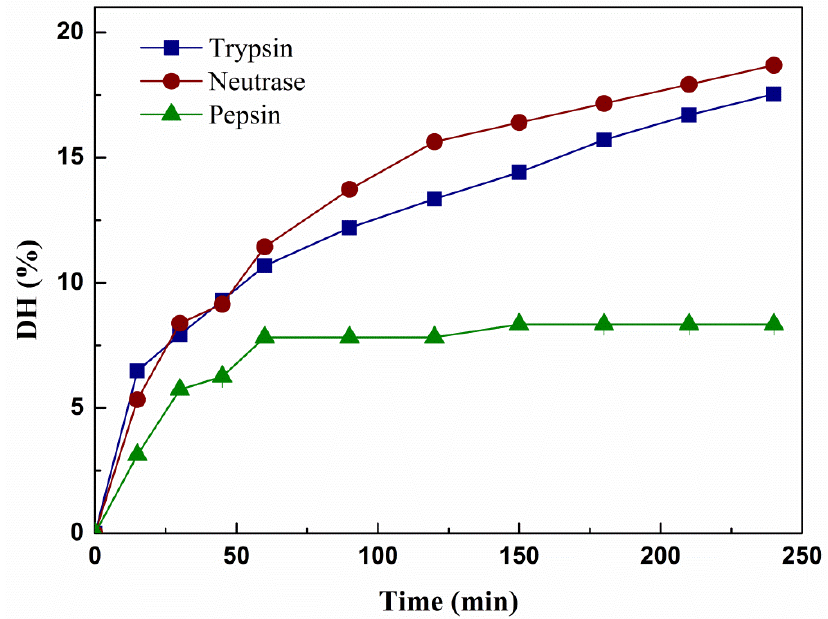
Figure 1. Changes of the degree of hydrolysis of R. philippinarum protein during hydrolysis by trypsin, neutrase and pepsin. Hydrolysis conditions: Neutrase 3.0%, 45 ◦ C, pH 6.5; Trypsin 3.0%, 45 ◦ C, pH 9.0. Pepsin 3.0%, 45 ◦ C, pH